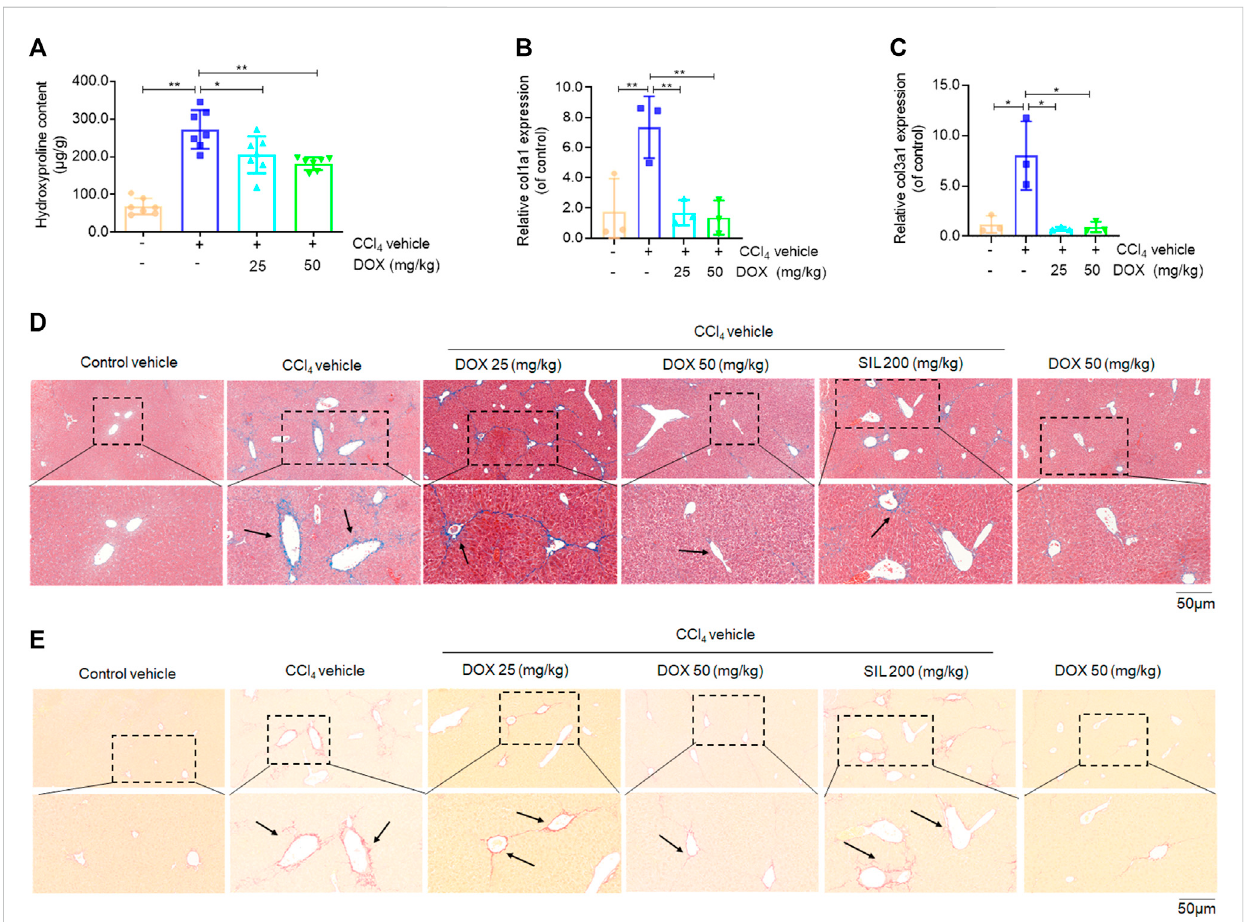
EffectsofDOXonliverhydroxyprolinecontent,serummarkersof fi brosisandlivercollagenexpression. (A) Liverhydroxyprolinecontent( n =7). (B,C) Liver Col1a1 (Collagen, type I, α 1) and Col3a1 (Collagen, type III, α 1) ( n = 3). (D) Liver masson ’ s trichrome staining. Typical images were chosen from each experimental group. Black arrows indicate collagen deposition. (original magni fi cation ×200, upper images; partial enlarged pictures, down images). (E) Liver sirius red staining. Typical images were chosen from each experimental group. Black arrows indicate collagen deposition. (original magni fi cation ×200, upper images; partial enlarged pictures, down images). Data were expressed as means ± SEM. * p < 0.05; ** p <